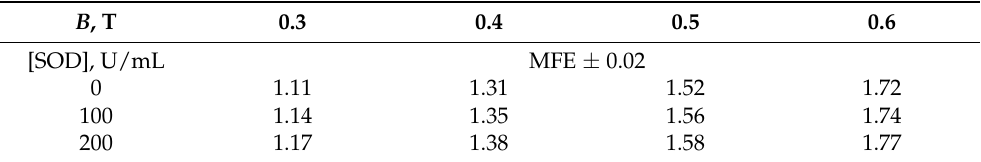
Table 6. Values of the magnetic field effect (MFE) for the initiated oxidation of adrenaline. Phos-